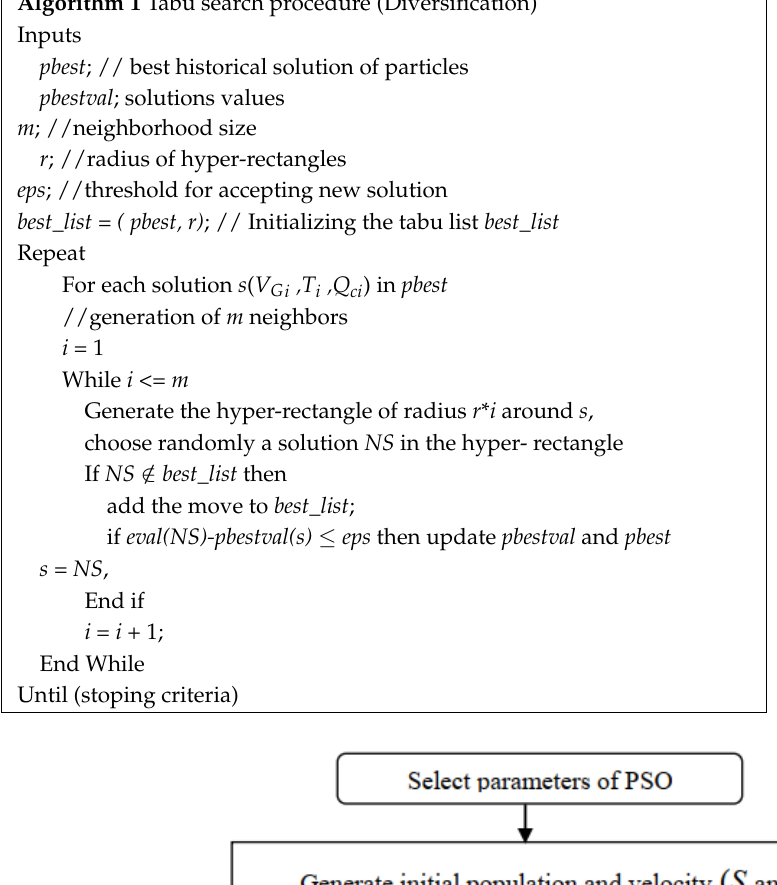
Algorithm 1 Tabu search procedure (Diversification)